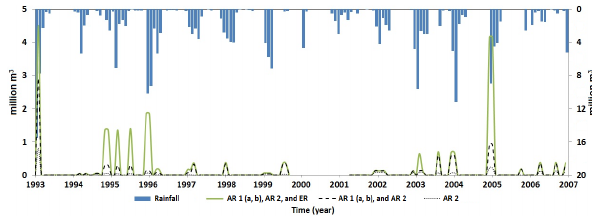
Fig. 10. Rainfall (right axis) and recharged water volume estimated by groundwater model (left axis) into the groundwater storage through both FWS systems (artificial recharge, AR 1 (a, b) and AR 2) and ephemeral river channel (natural recharge, ER) for the years between 1993 and 2007.